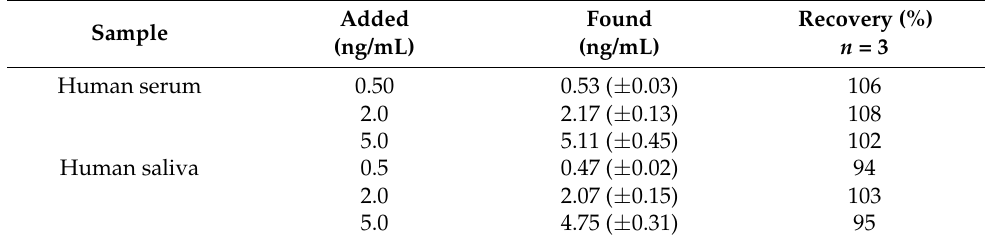
Table 1. Detection of AFP in human saliva and serum samples.